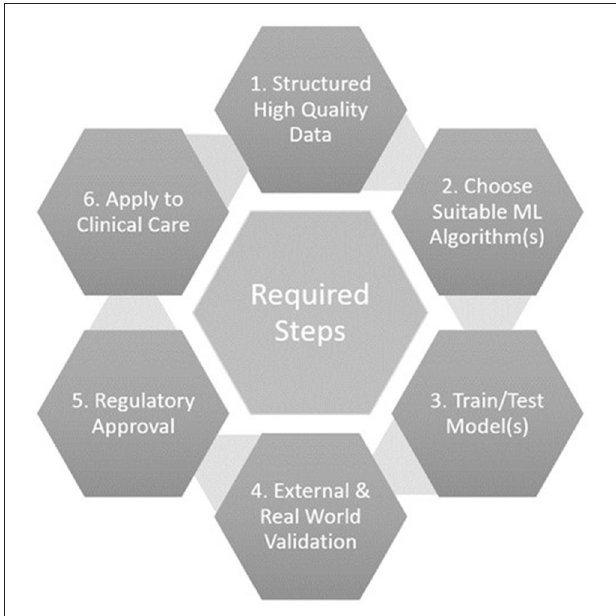
FIGURE 2 | Key steps required for using machine-learning for echocardiographic diastolic analysis.